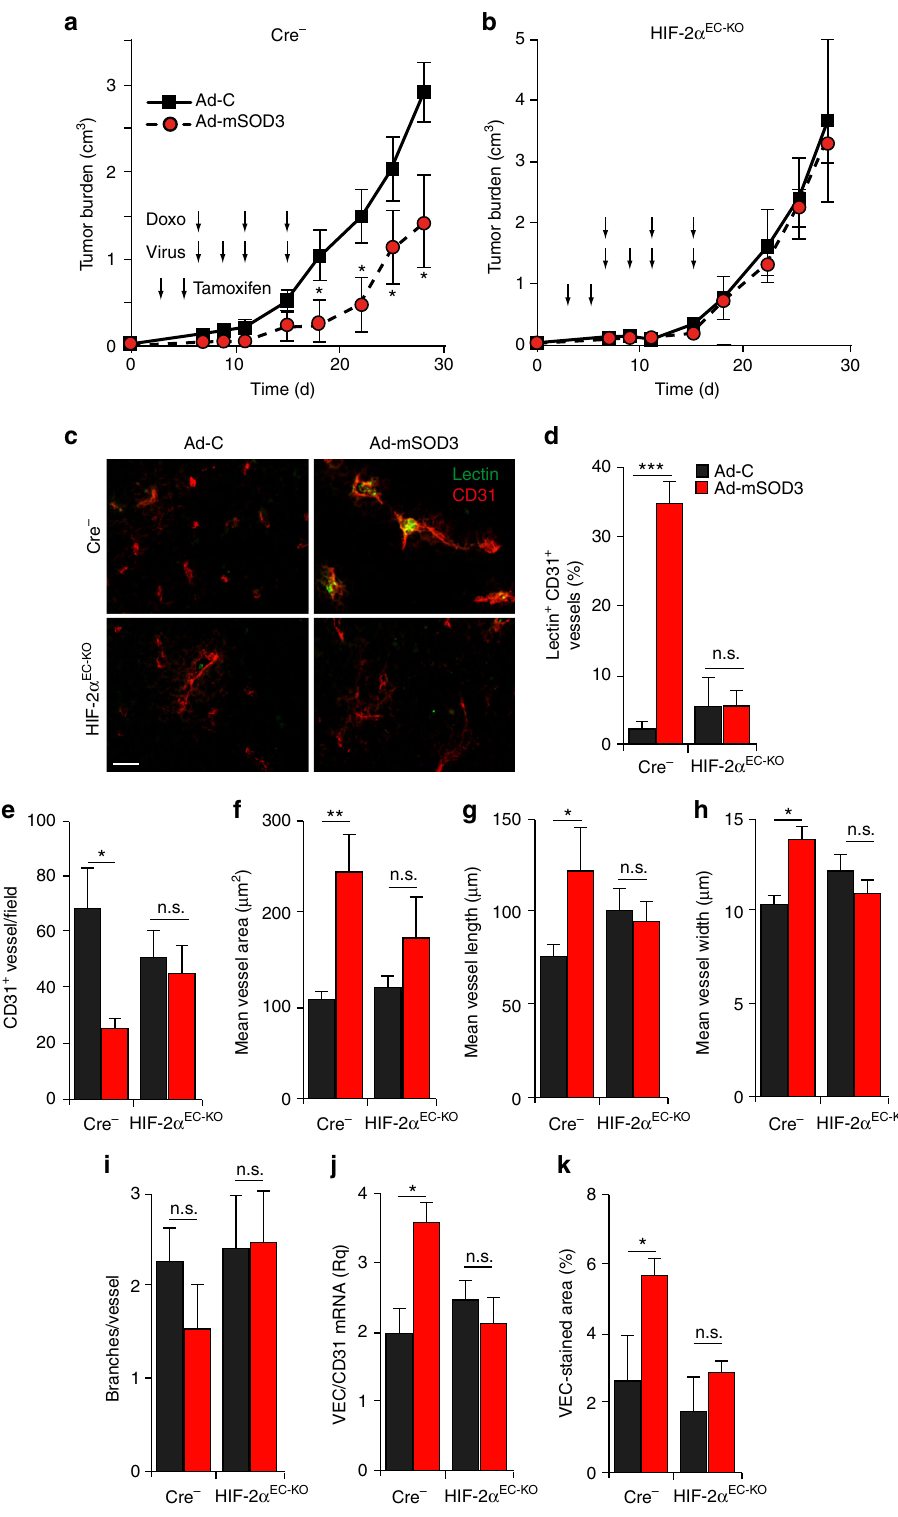
Fig. 7 Speci fi c HIF-2 α ablation in EC abolishes in vivo SOD3 effects. a , b Growth kinetics of Ad-C- or Ad-mSOD3-injected LLC tumors grafted in control (Cre − ; a ) or HIF-2 α EC-KO mice ( b ). c , d Images of lectin-FITC-perfused (green), CD31-stained (red) vessels in tumors resected at day 18 ( ≤ 1 cm 3 ) from control and HIF-2 α EC-KO mice. e – i Vessel density ( e ), mean area ( f ), length ( g ), diameter ( h ), and branching ( i ) determined by CD31 + staining in tumors from a , b ( n ≥ 25 fi elds/condition). j VEC mRNA levels, normalized to those of CD31, in tumors in a , b . k VEC-stained area as a percentage of VEC staining in CD31 + structures in images of tumors in a , b (see also Supplementary Fig. 10c – f); n = 10 – 20 images/group. * p < 0.05; ** p < 0.01; *** p < 0.001; two- tailed Student ’ s t -test. Bar, 50 μ